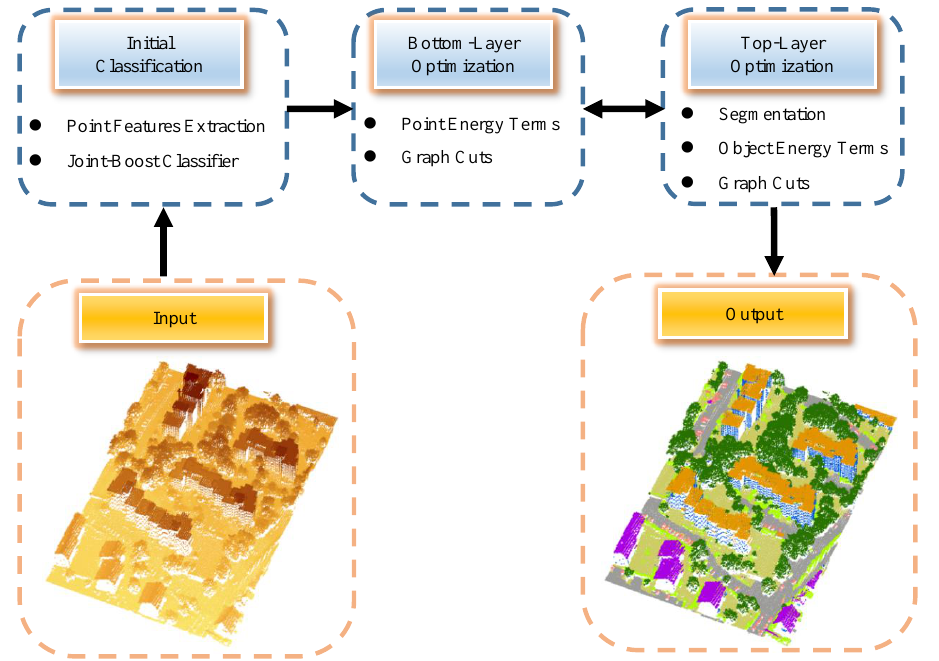
Figure 1. The flow chart of the proposed two-layered graph cuts classification framework.